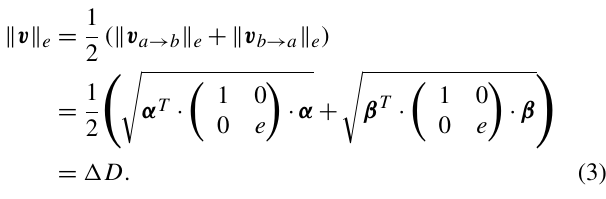
P (m,n) gives the probability of segment m and n being